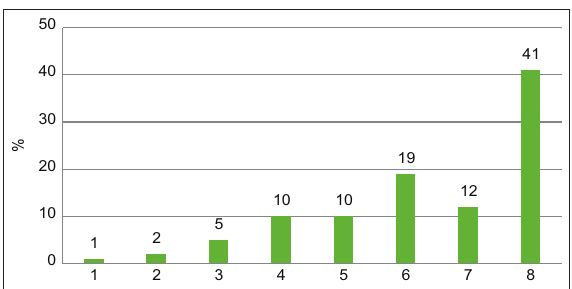
CHART 2. Display instrumental activities of daily living score from lowest to